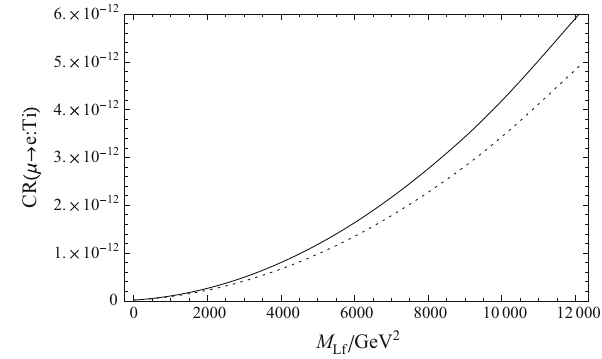
Fig. 8 With m 1 = 1000GeV, tan β = 2 . 0, S 2 m = 12TeV 2 , tan β L = 2 . 0, g L = 1 and V Lt = 3000GeV, μ → e conversion rate in nuclei 6 Ti versus M Lf with m 2 = 1000GeV (solid line) and 2000 GeV(dotted line)